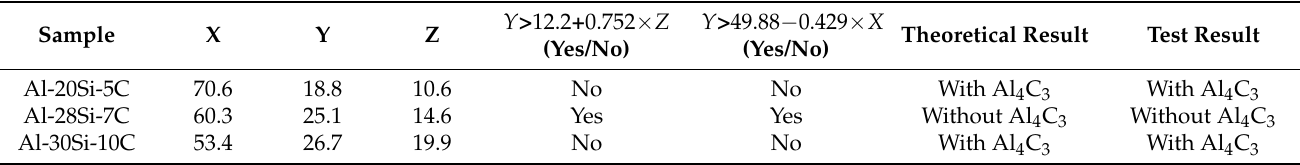
Table 3. Verification comparison between theoretical calculation results and experimental results on whether Al 4 C 3 is contained in Al-Si-C